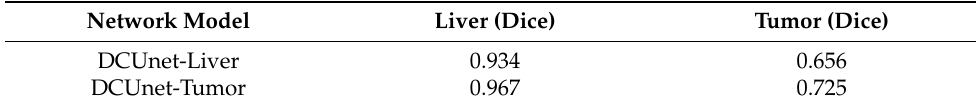
Table 3. The Dice coefficient of the liver and tumor at various stages.